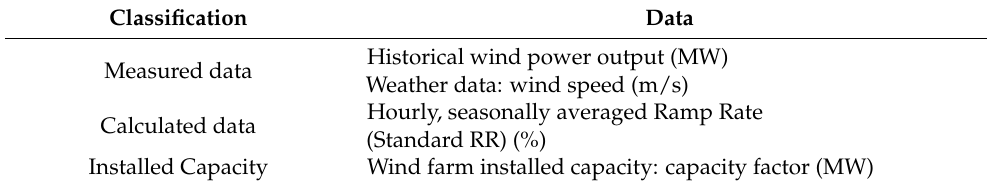
Table 1. Overview of the input